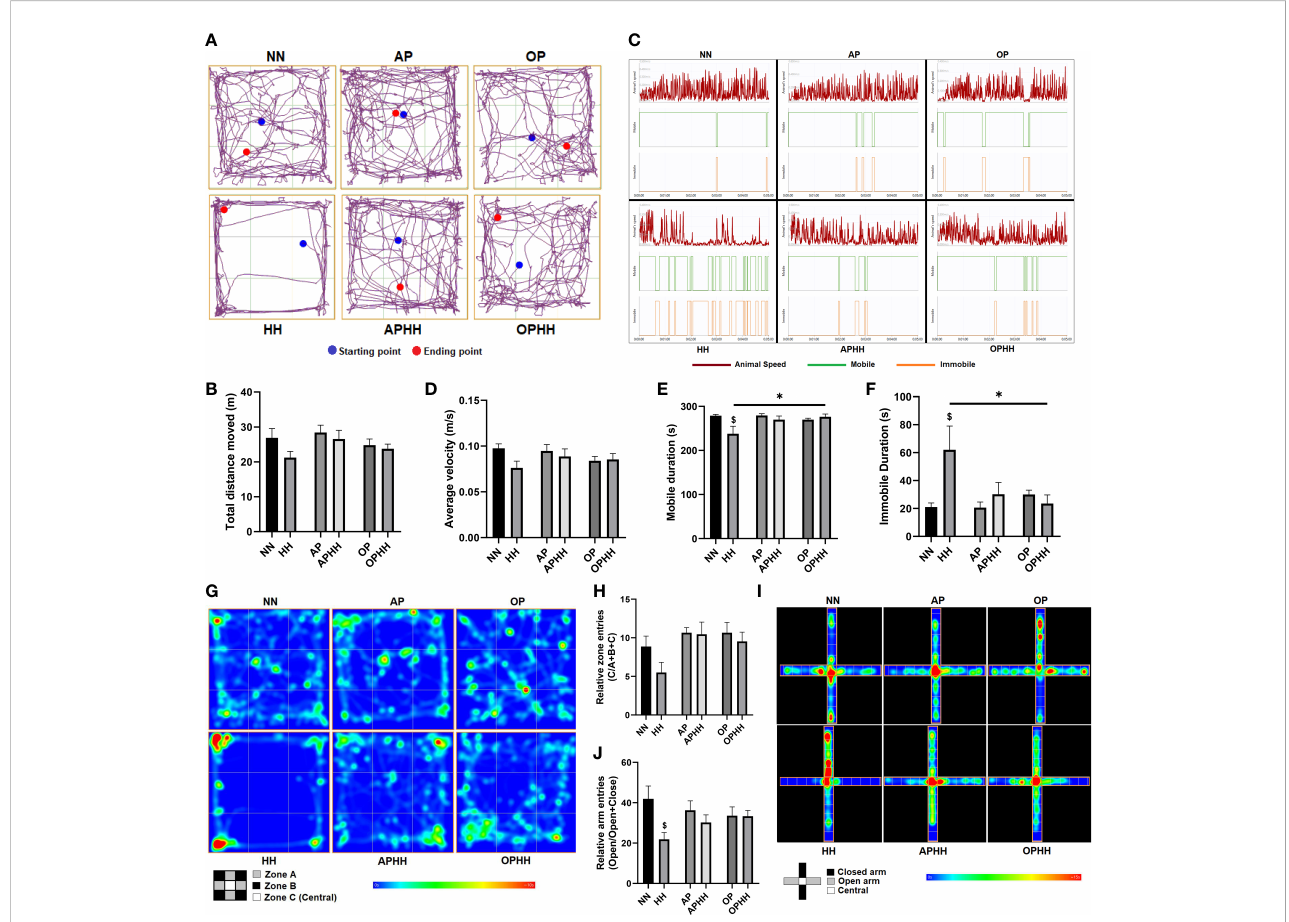
FIGURE 5 OPHH mice are resilient to HH-associated maladaptive behavioral outcomes. (A-H) Locomotive and exploratory behavioral assessment indexes from Open fi eld test (OFT), including; Representative plots of Total distance moved and its graphical presentation, Representative plots of Average velocity, Mobile duration, and Immobile duration, and their graphical presentations and Representative heat-maps of Relative zone entries and its graphical presentation (n=6-10 mice per group). Normobaric Normoxia (NN), Hypobaric Hypoxia (HH), Altitude Preconditioned (AP), Altitude Preconditioned before HH exposure (APHH), Occlusion Preconditioned (OP), and Occlusion Preconditioned before HH exposure (OPHH) mice. (I, J) Anxiety-related and exploratory behavioral assessment indexes from Elevated plus maze (EPM), including; Representative heat-maps of Relative arm entries and its graphical presentation (n=6-10 mice per group). $ p<0.05 HH vs NN; *p<0.05. Data are expressed as mean ± SEM. Data were analyzed using one-way ANOVA, followed by Tukey ’ s post hoc